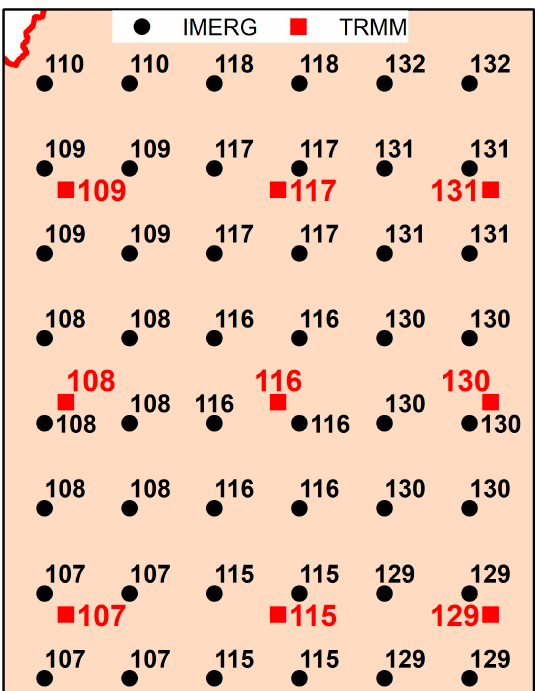
Figure 3. A schematic showing a layout of the Tropical Rainfall Measurement Mission (TRMM) (rectangle in red color at a spatial resolution of 0.25 deg.) and the Integrated Multi-satellite Retrievals for the Global Precipitation Measurement mission (IMERG) (circular in black color at a spatial resolution of 0.1 deg.) grids labelled with numbers illustrating nearest neighbor connectivity. TRMM data from March 2000 to March 2014 were used to fill the IMERG grids following the joining methodology explained.